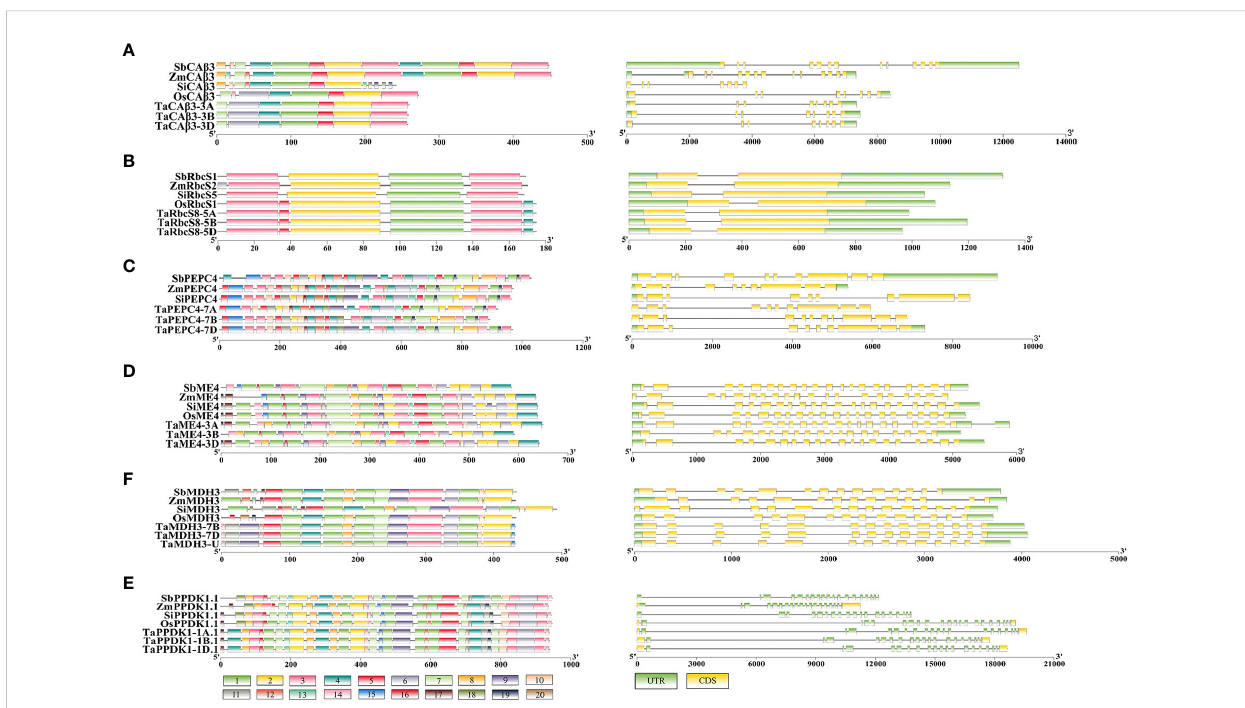
FIGURE 2 The gene structures and conserved protein domains of putative C 4 /C 4 -homologous genes in fi ve gramineous crops. (A – E) represent b -CA, RbcS, PEPC, ME, MDH, and PPDK, respectively. The graph on the left is the distribution of conserved motifs on these proteins, and the right panel is the gene